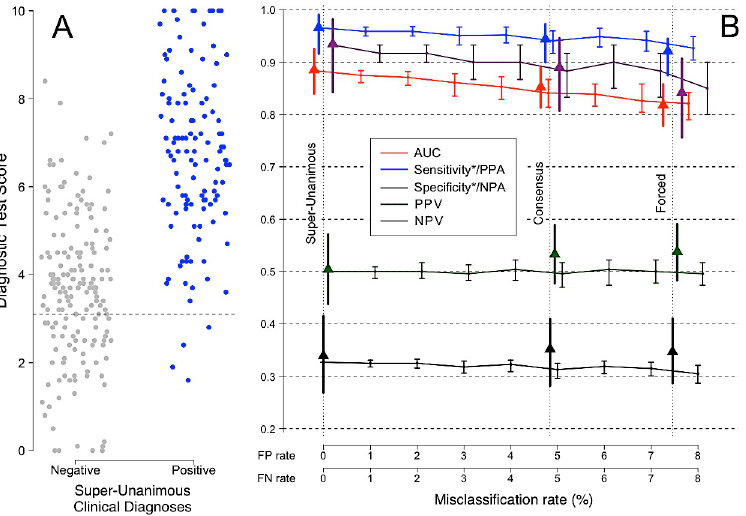
Fig 7. (A) Real data from a clinical trial for a new sepsis diagnostic test, conducted over 8 sites in the USA and Netherlands [25]. (B) The apparent performance of the test (y axis) decreases as uncertainty is introduced into the comparator (x axis). 95% confidence intervals are shown. The difference between the apparent test performance at a given comparator misclassification rate and at a comparator misclassification rate of zero indicates the degree of underestimation of true test performance due to uncertainty in the comparator. The vertical lines mark the observed misclassification rates for various patient subsets within the same trial, as described in the text. Misclassification rates are based on quantifying the discordance between independent expert opinions. Solid triangles show the observed measurements for the trial for each of these groups without correction for comparator uncertainty. Sensitivity/PPA and Specificity/NPA are each marked with an asterisk ( � ) to emphasize that these measures assume no misclassification in the comparator. Positive Percent Agreement (PPA) and Negative Percent Agreement (NPA) are the correct terms to use, when the comparator is known to contain uncertainty as in this case.